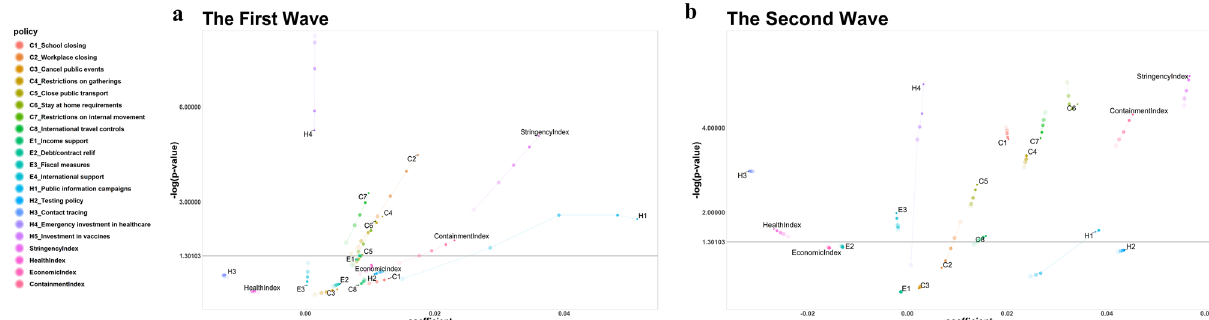
Figure 2. Lagging effect in the wave-specific analysis. Variation of coefficients and p values of policies and indices in the first wave analysis is shown. The size and transparency of the points increase with a time lag (0, 3, 7, 10, 14). ( a ) first wave analysis shows C2, C4, C7, H4, SI, and RI were significant at all-time lags while C8 and E3 were with lagging only. ( b ) second wave analysis shows C1, C5, C6, E3, H1, H3, HI, CI and CoI are significant at all-time lags while C8 at 14 days’